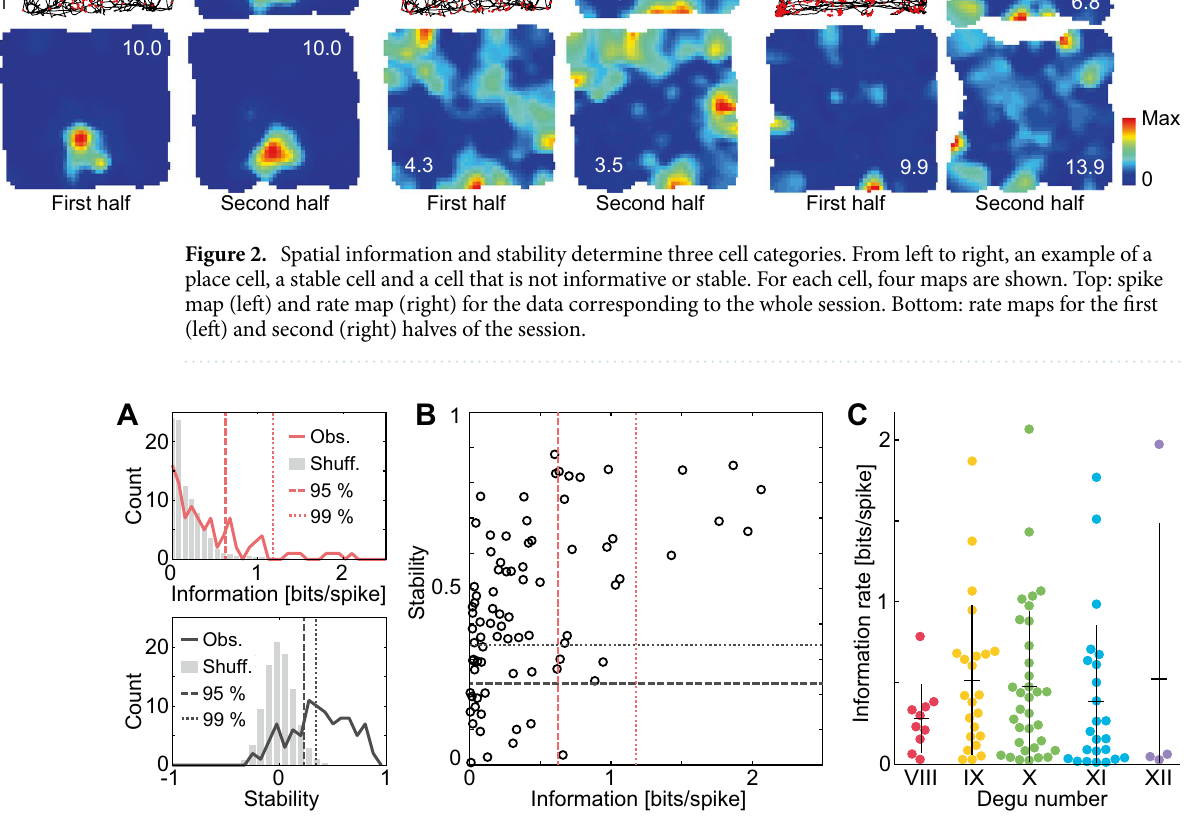
Figure 3. Statistics of spatial information rate and stability across cells and degus. ( A ) Spatial information rate (top) and stability (bottom) for the observed (color) and shuffled (grey; normalized by number of shuffles) distributions. Dashed lines indicate the 95th (information: 0.6 bits s −1 , stability: 0.23) and 99th (information: 1.2 bits s −1 , stability: 0.34) percentiles of the shuffled distribution. ( B ) Stability and information rate for individual cells (one circle per cell). Dashed lines as in ( A ). ( C ) Distribution of spatial information rate across